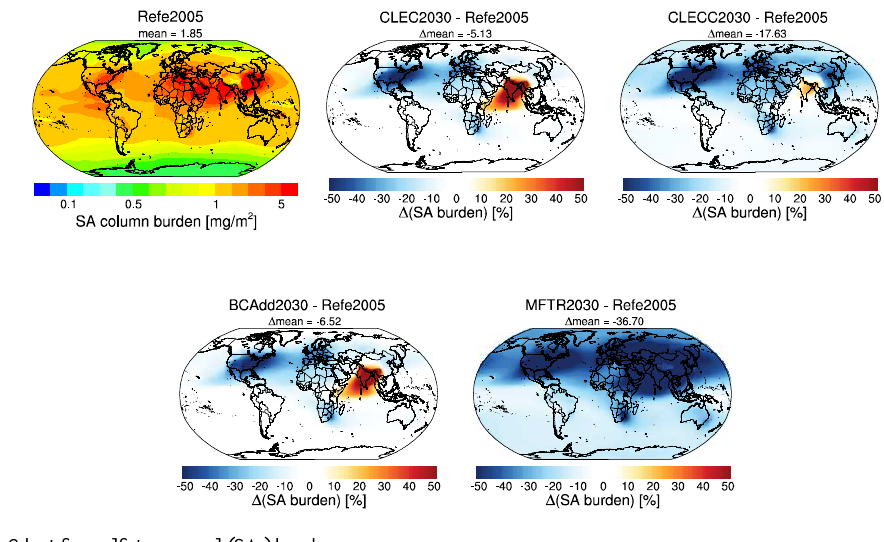
Figure 4. Like Fig. 2 but for sulfate aerosol (SA)